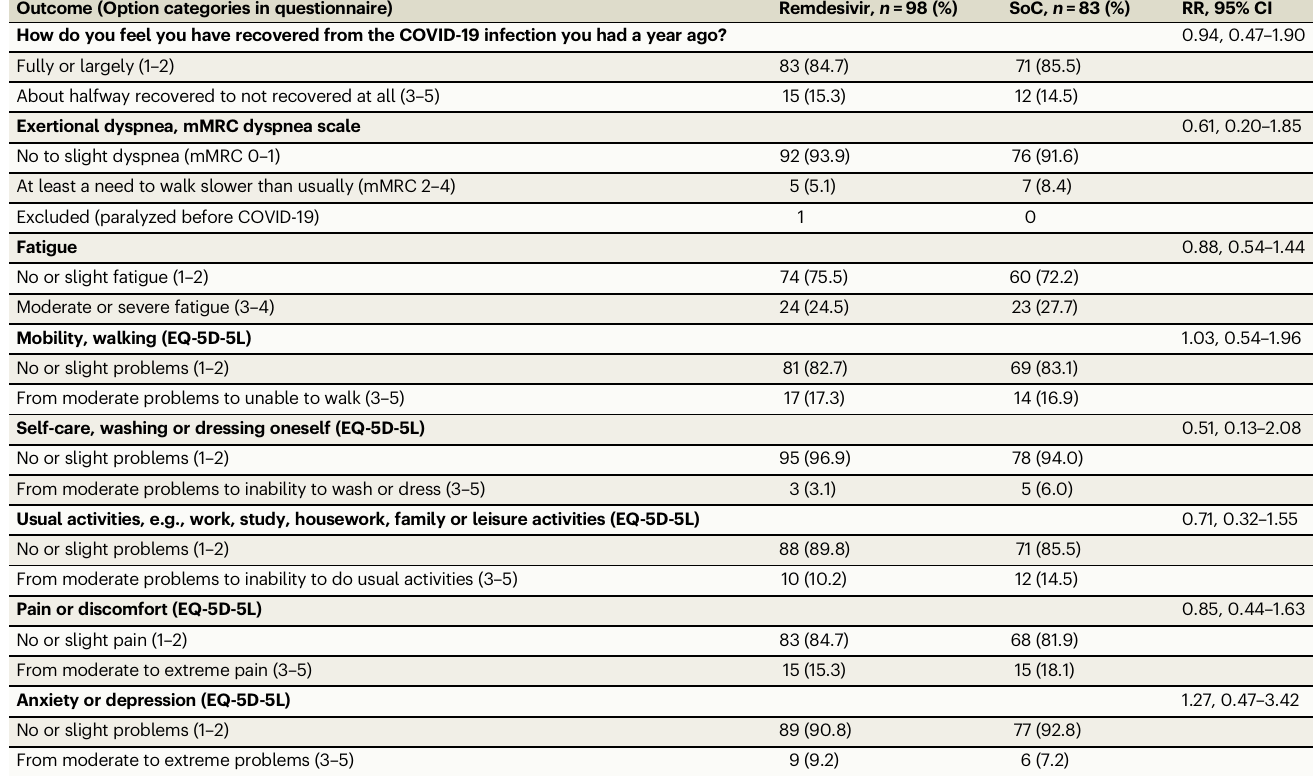
Table 2 | Effect of remdesivir plus standard of care (SoC) compared to SoC only on patient-relevant outcomes after 1 year from hospitalization due to COVID-19-infection Outcome (Option categories in